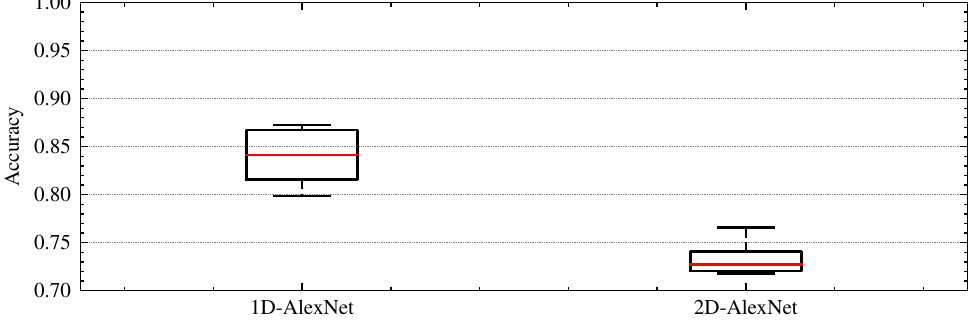
Figure 11. Box and whisker plot for the distributions of accuracy scores of 1D-AlexNet and 2D- AlexNet obtained with the Dietterich’s 5 2cv paired t -test (considering the augmented dataset). × Boxes extending from the first quartile below to the third quartile above. The median line is in red, and whiskers extend to the minimum and maximum